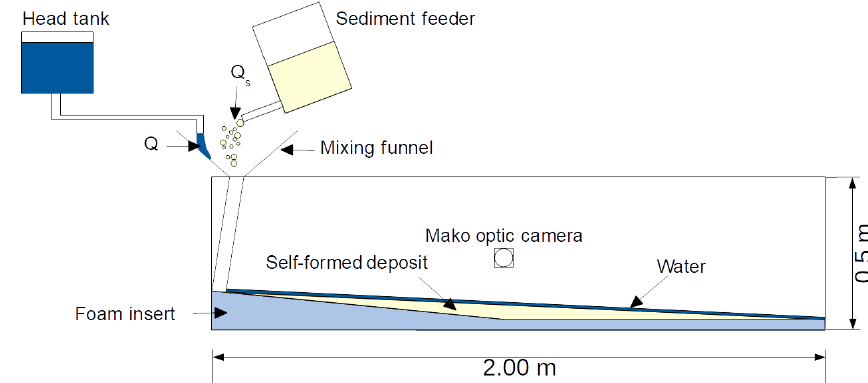
Figure 1. Simplified diagram of the experimental setup for the steep channel